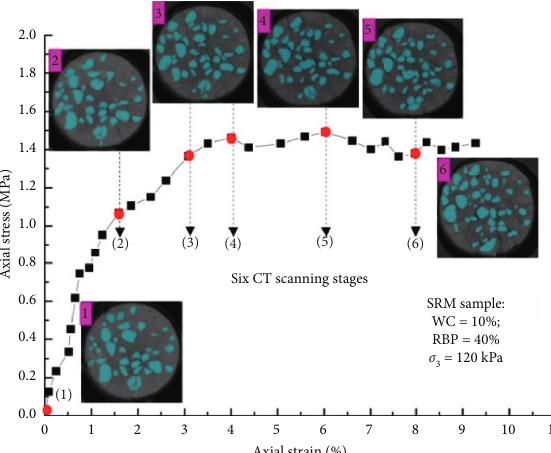
Figure 3: Drawing the axial stress-strain curve of the studied bimrock specimen, and selecting 6 key points for CT